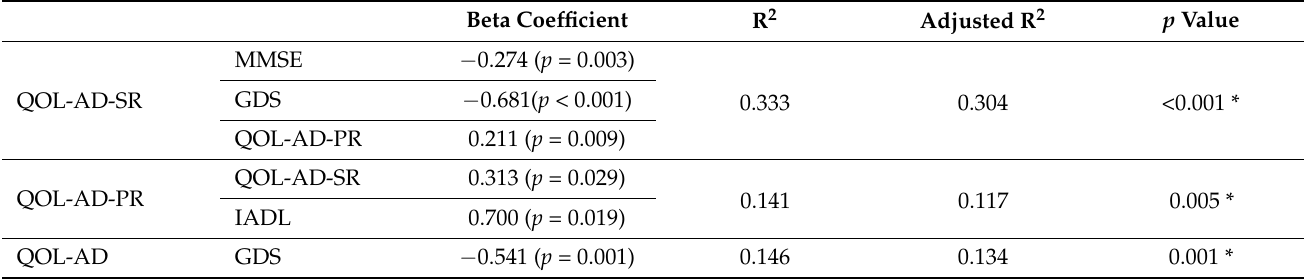
Table 3. Regression models of factors predicting quality of life in Alzheimer’s disease, quality of life in Alzheimer’s disease—self-rated and quality of life in Alzheimer’s